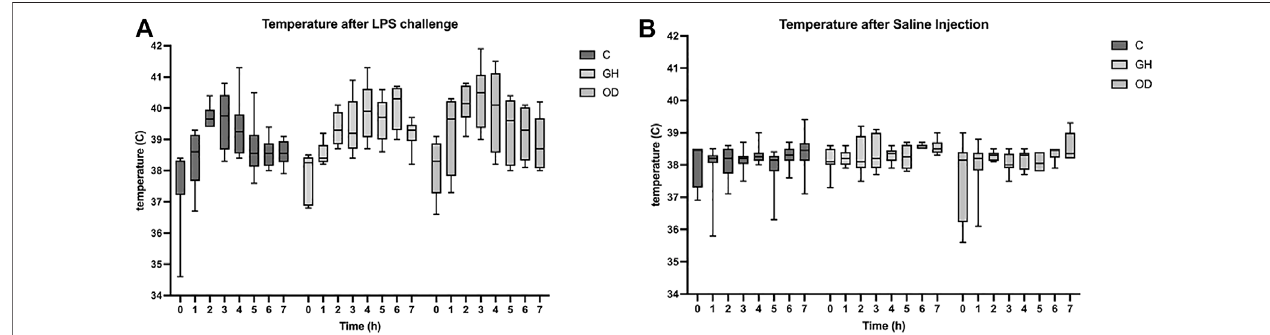
FIGURE 1 | Rectal temperature of gilts measured the day before lipopolysaccharide (LPS) or saline (SAL) challenges (T0) or one hour apart up to 7 h (T1 – T7) after LPS challenge (A) or SAL challenge (B) in indoor group-housing (GH) ( n = 14), outdoor group-housing (OD) ( n = 13), and crates (C) ( n = 9). (*) Statistical signi fi cance ( q < 0.001) in rectal temperature in all groups at 3 h after LPS-challenge, but no housing effect. (**) Statistical signi fi cance ( q < 0.008) in rectal temperature in all groups at 6 h after SAL-challenge, but no housing effect.